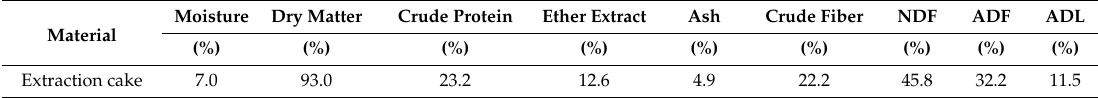
Table 8. Additional analysis carried out on extraction